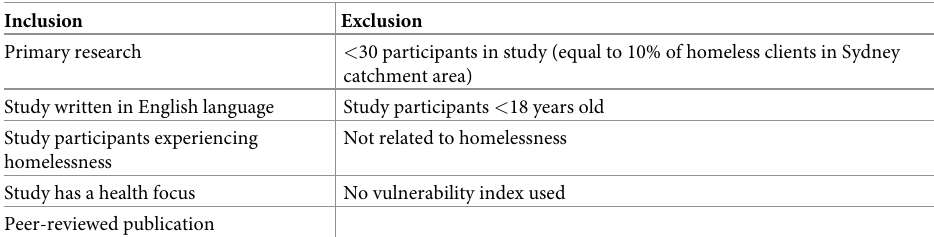
Table 1. Inclusion and exclusion